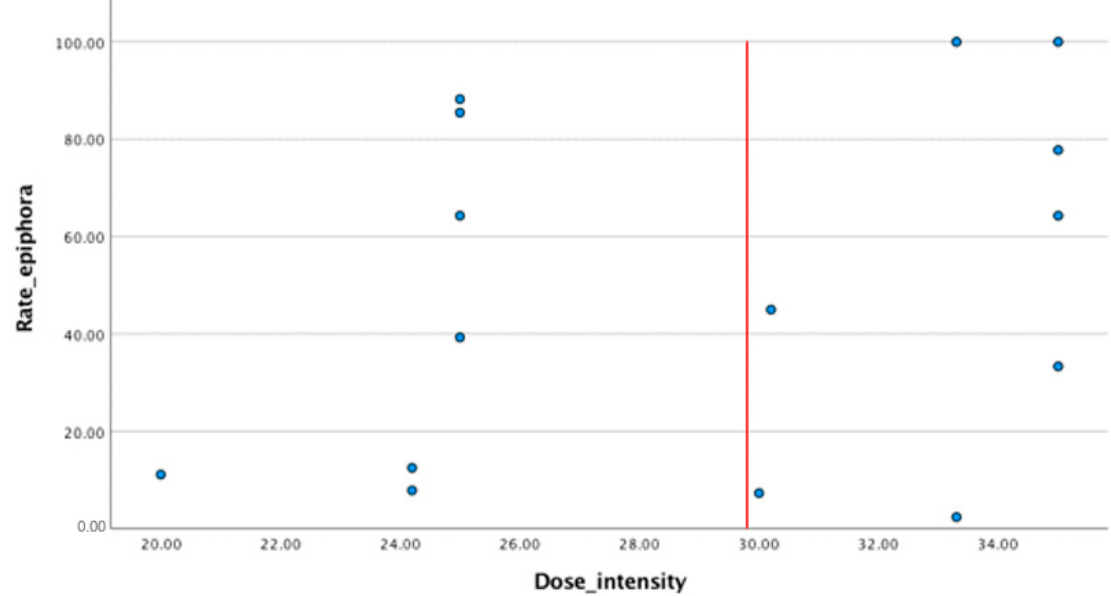
Figure 4. The distribution of rate of epiphora by dose intensity is approximately equal related to the red line. The red line represents the median value of the dose intensity (=30 mg/m 2